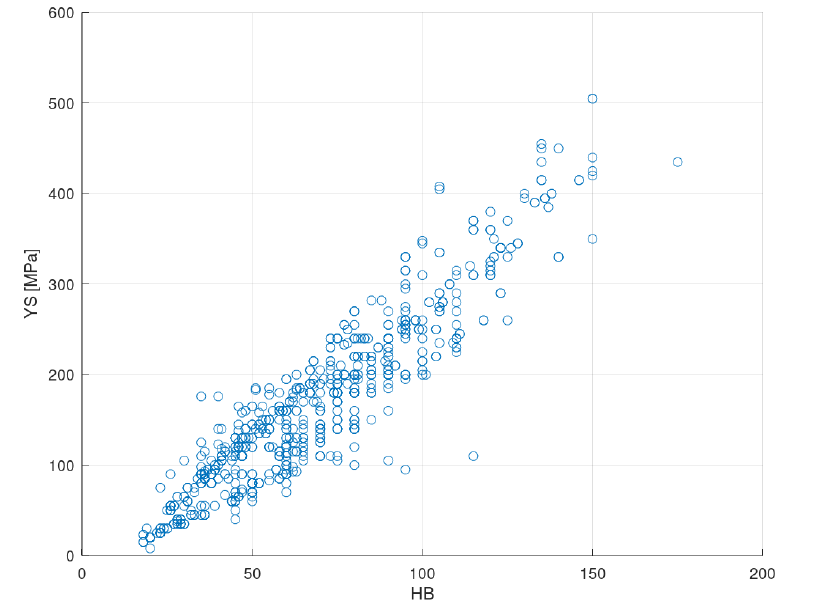
Figure 6. Yield strength-Brinell hardness scatter plot of the input dataset.